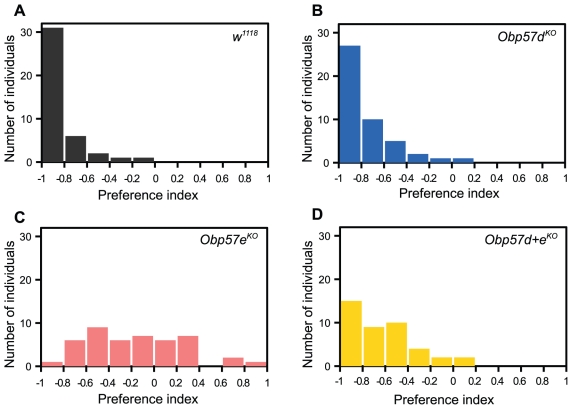
Behavioral response to tridecanoic acid in the OBP mutants.Behavioral responses of the D. melanogaster knockout flies for Obp57d and Obp57e to tridecanoic acid were examined by the oviposition site selection assay. Preference index (PI) = (Nacid−Ncont)/(Nacid+Ncont), where Nacid and Ncont are the number of eggs laid on tridecanoic acid-containing and control media, respectively. A total of 48 individuals were examined in the six independent replicates. (A) w1118, (B) Obp57dKO, (C) Obp57eKO, and (D) Obp57d+eKO.